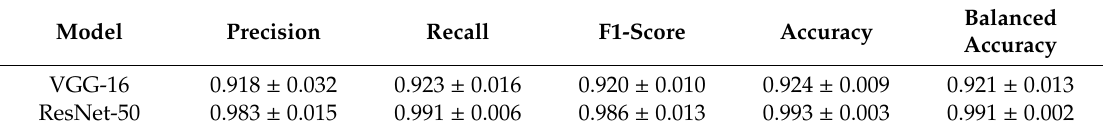
Table 2. Performance evaluation on our proposed method and VGG-16 pretrained model.